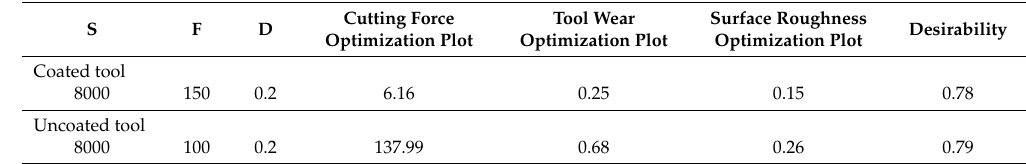
Table 12. The response optimization